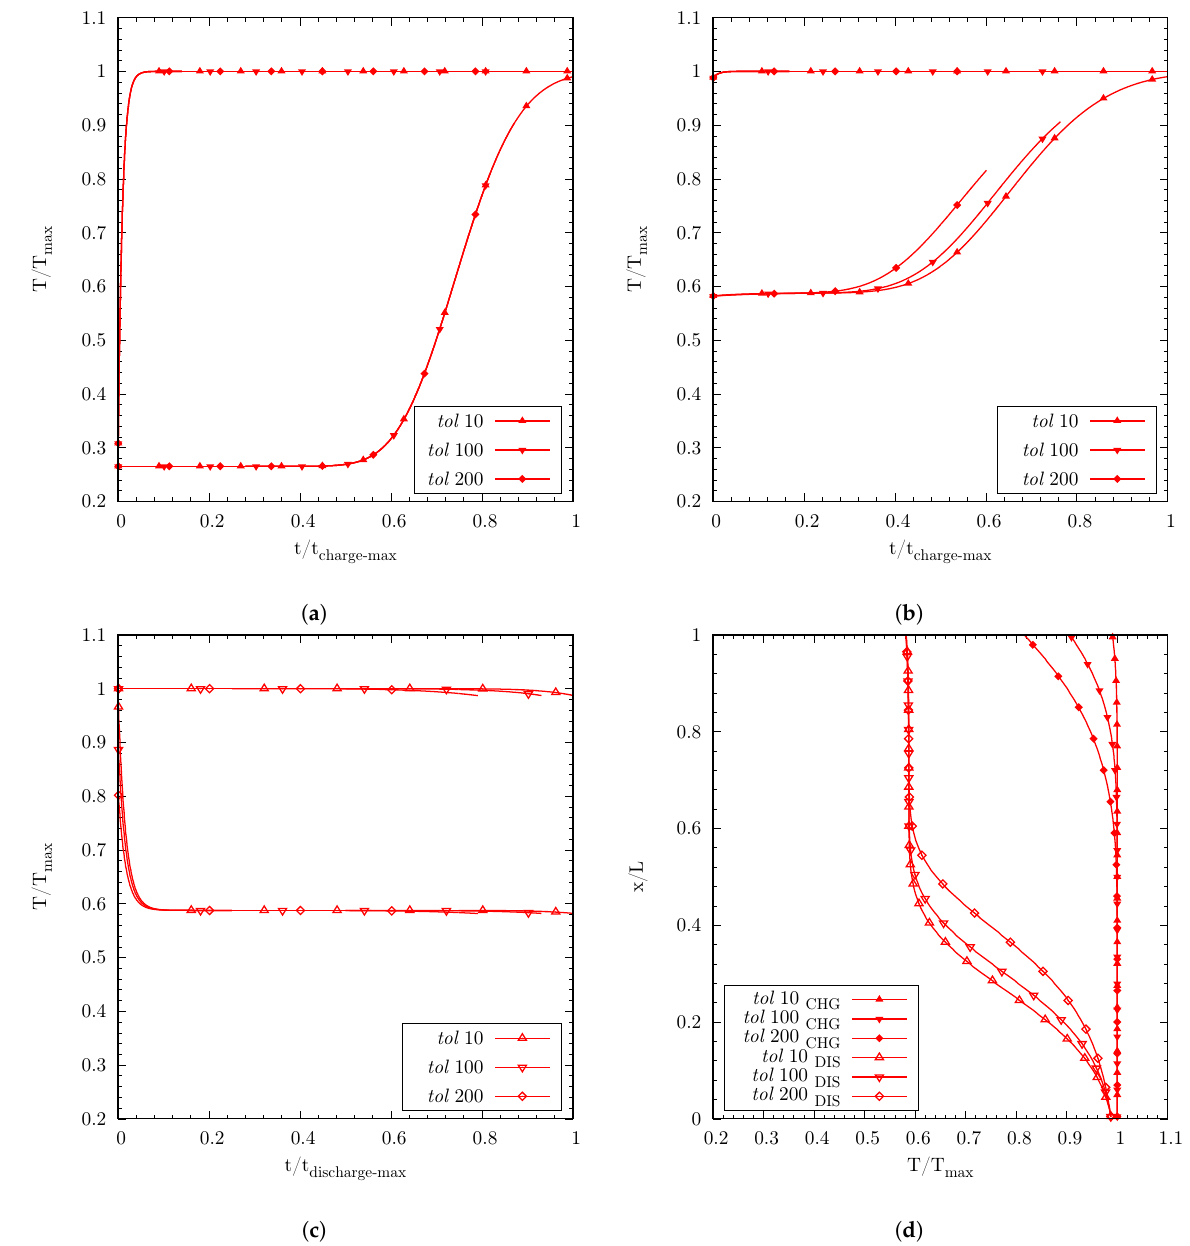
Figure 7. Comparisons of the model m.3 non-dimensional curves of temperature over time when the charging tolerance are different. The charging tolerance’s values were 10, 100 and 200, which are temperature differences between T max and the air temperature at the tank’s outlet. ( a ) First charge temperature trends over time, ( b ) first stable cycle charge temperature trends, ( c ) first stable cycle discharge temperature trends and ( d ) temperature distributions inside the tank at the end of the first stable cycle’s charge (CHG) and discharge